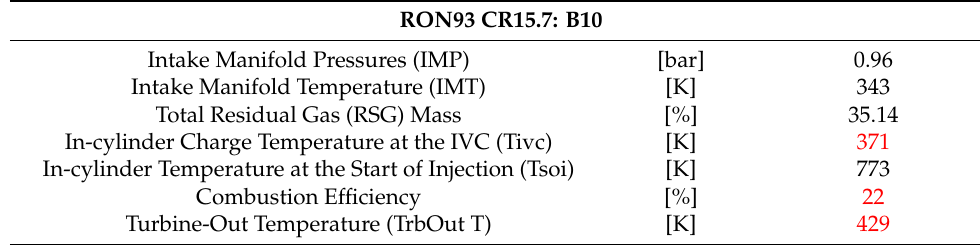
Table 2. Simulated GCI performance at B10.